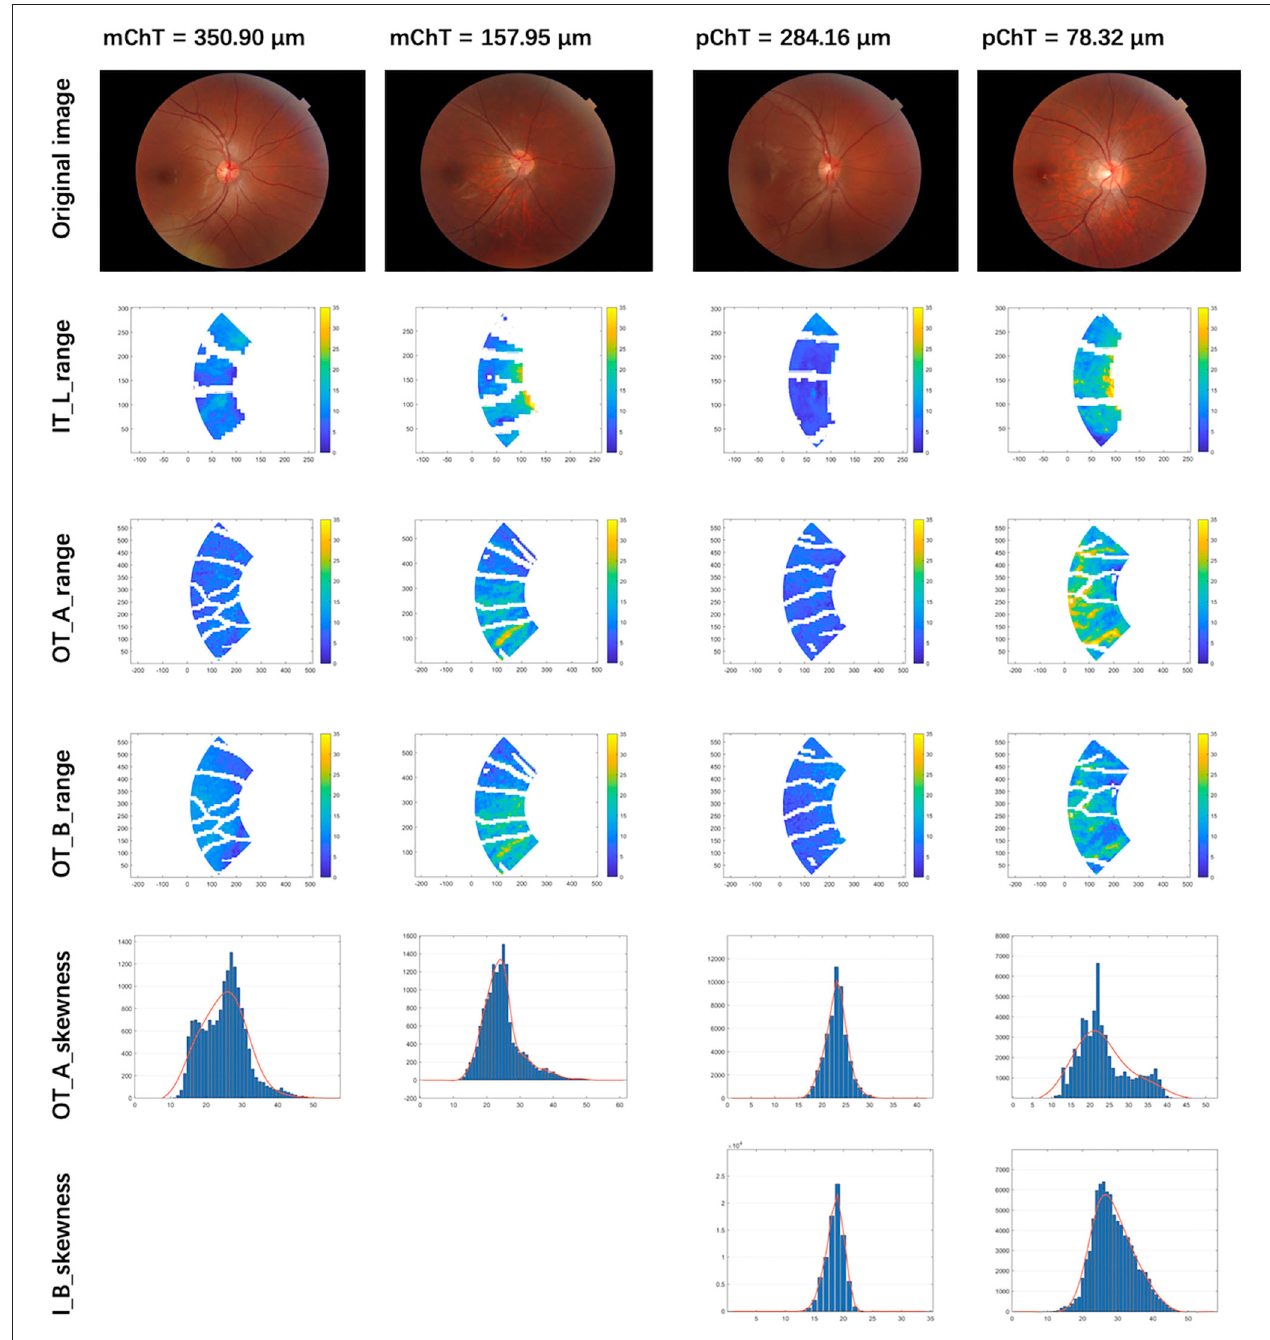
FIGURE 4 | Visualization of selected radiomic features. Column 1 and 2: patients with macular choroidal thickness (mChT) of 350.90 and 157.95 µ m. Column 3 and 4: patients with peripapillary choroidal thickness (pChT) of 284.16 and 78.32 µ m. Row 1: original images. Row 2: range of intensity in L channel of the inner temporal region (IT_L_range); Row 3: range of intensity in A channel of the outer temporal region (OT_A_range); Row 4: range of intensity in B channel of the outer temporal region (OT_B_range). Row 5: skewness of intensity in A channel of the outer temporal region (OT_A_skewness); Row 6: skewness of intensity in B channel of the inner ring (I_B_skewness). Higher values of range mean larger variations of intensity in the LAB channel of color. Higher values of skewness mean larger proportions of the brighter region. IODs and ChT, even in the highly myopic group.